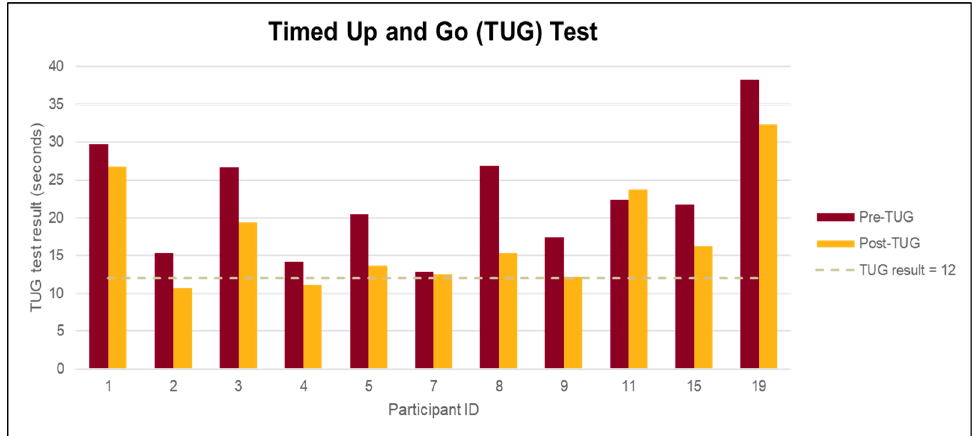
Figure 2. Timed Up and Go (TUG) ≥ 12 s indicates high risk for falling; n = 11. Longer times indicate higher risk for falling. Table 1. FES-I, TUG, and Older People’s Quality of Life (OPQOL) Results. Measures FES-I TUG OPQOL Pre Post Pre Post Pre Post Mean (SD)